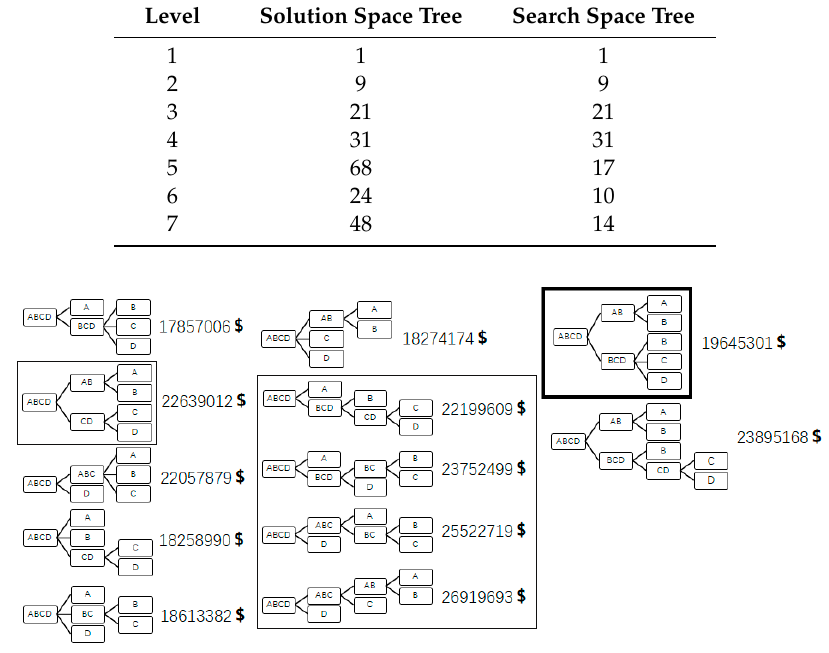
Table 9. Comparison of node numbers between the solution space tree (before pruning) and the search space tree (after pruning) of the four-component alkane case.